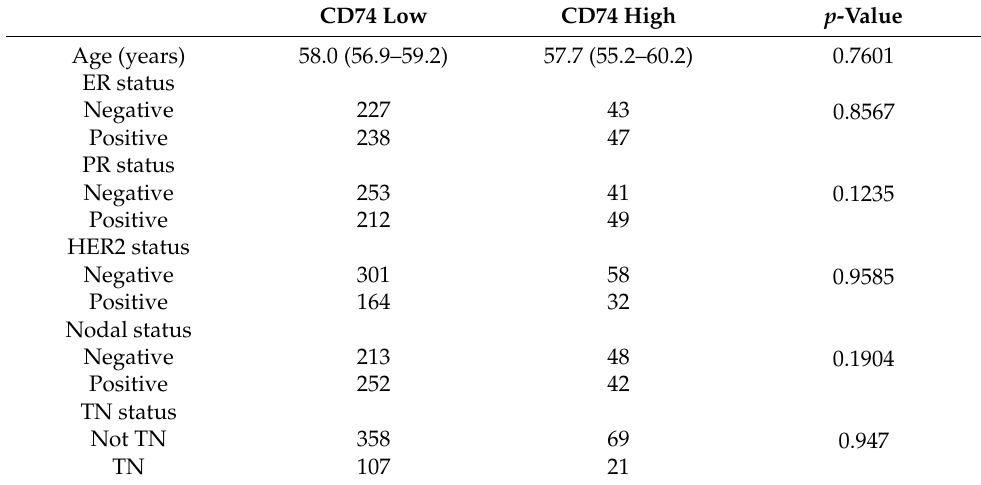
Table 2. Low/high score association with pathology scores, nodal status and TN status (categorical variables). CD74 Low CD74 High p